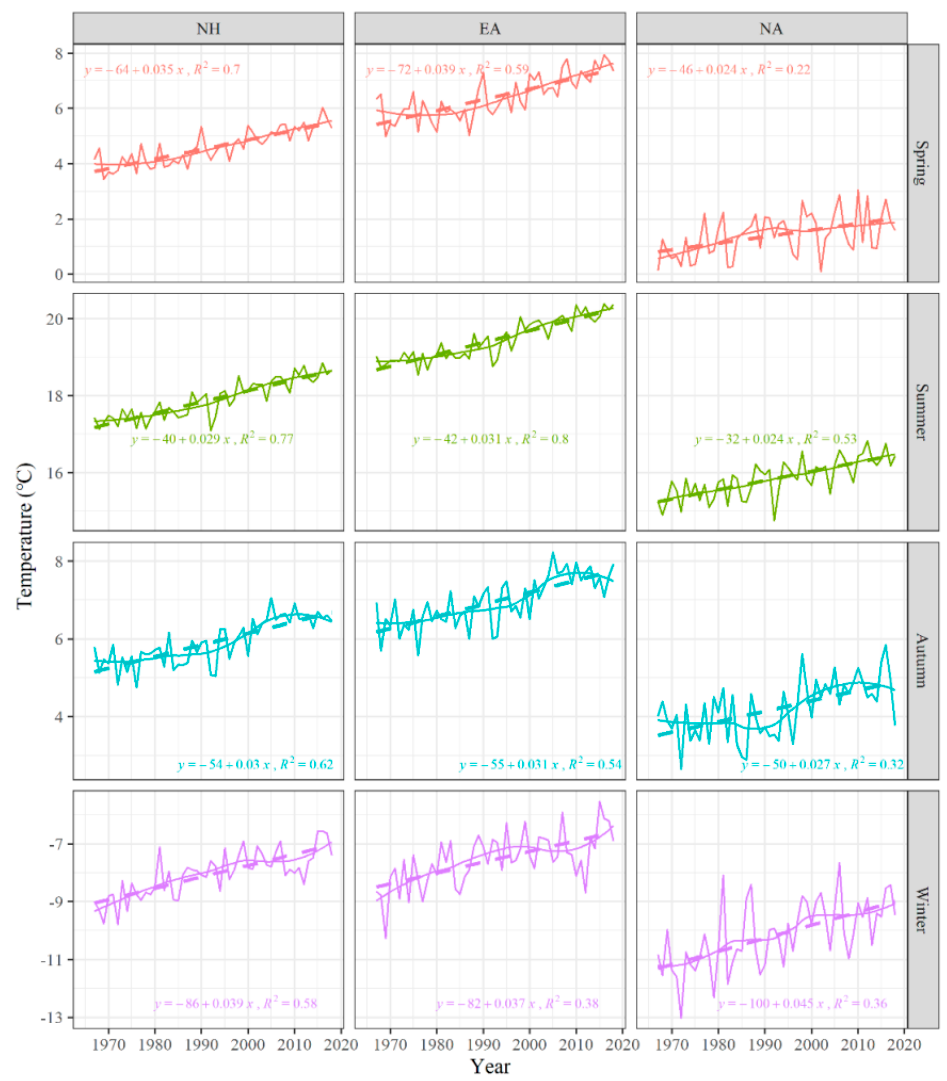
Figure 4. Variability in seasonal temperature across the NH, EA, and NA during the 1967–2018 period, with 10-year LOESS-smoothed values. Equations in the figure are for fitted linear regressions (dashed lines).